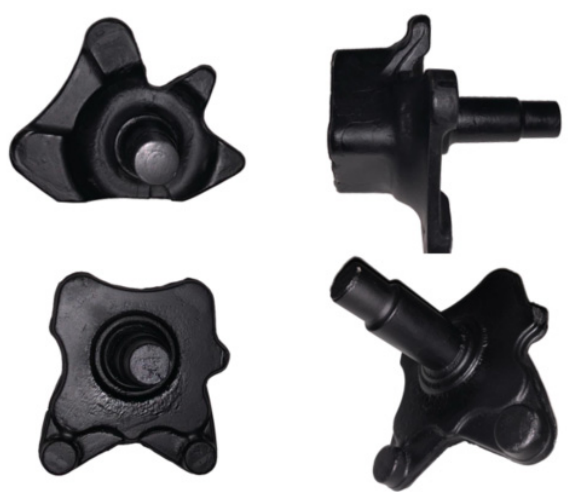
Figure 6. R and H components obtained using the NSF process.